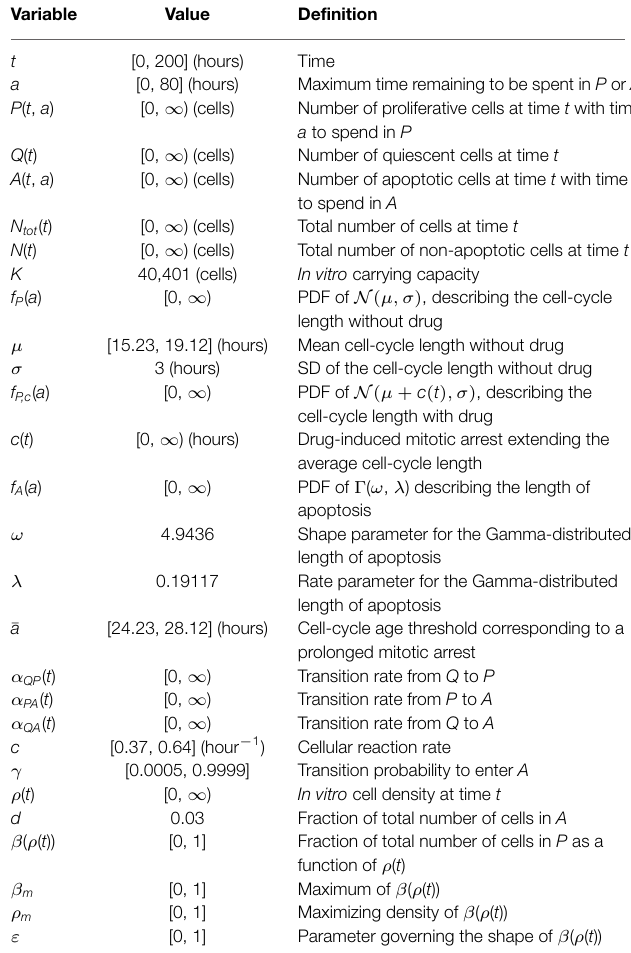
TABLE 1 | List of variables and parameters used throughout the model.